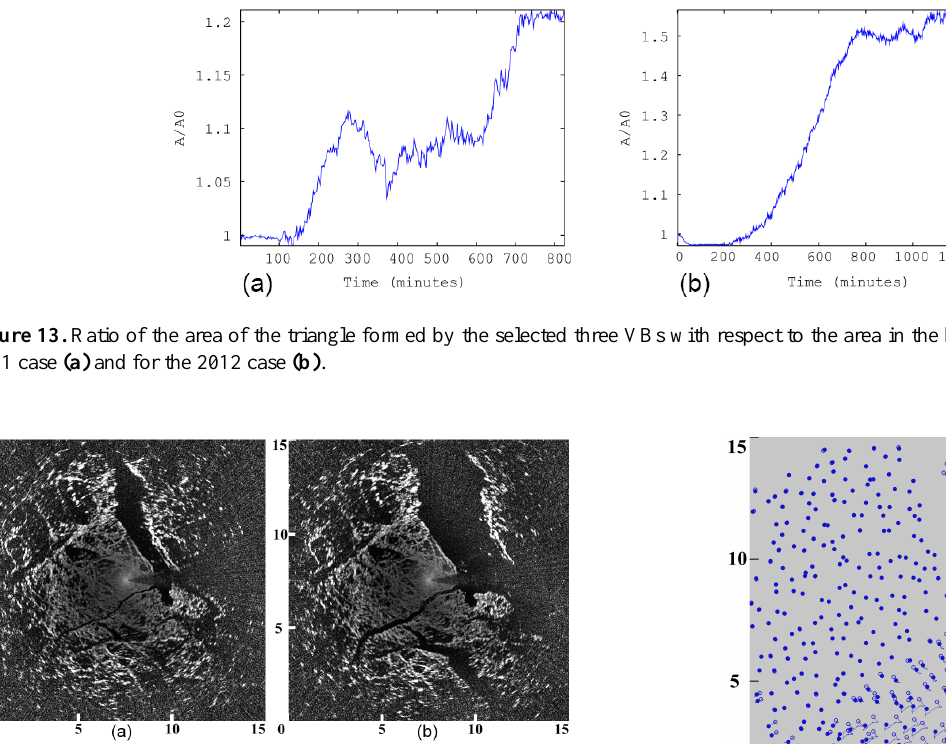
Figure 14. The first and last radar images of the RV Lance 1-day test period. The ship radar is located in the middle of the image. The associated scale is in kilometres.